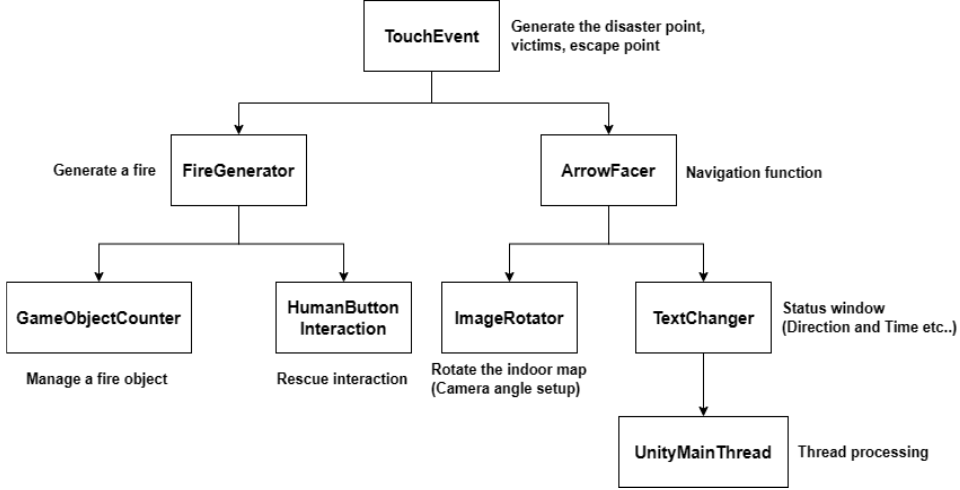
Figure 11. Specification of the MR system.